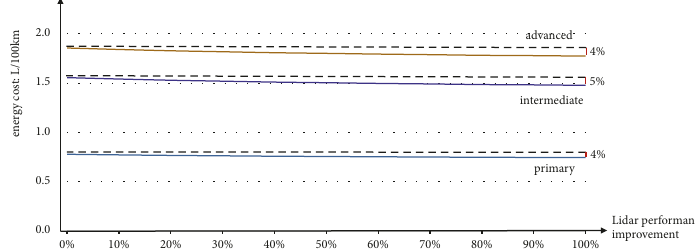
Figure 7: Fuel consumption cost of intelligent vehicle under LiDAR performance improvement.